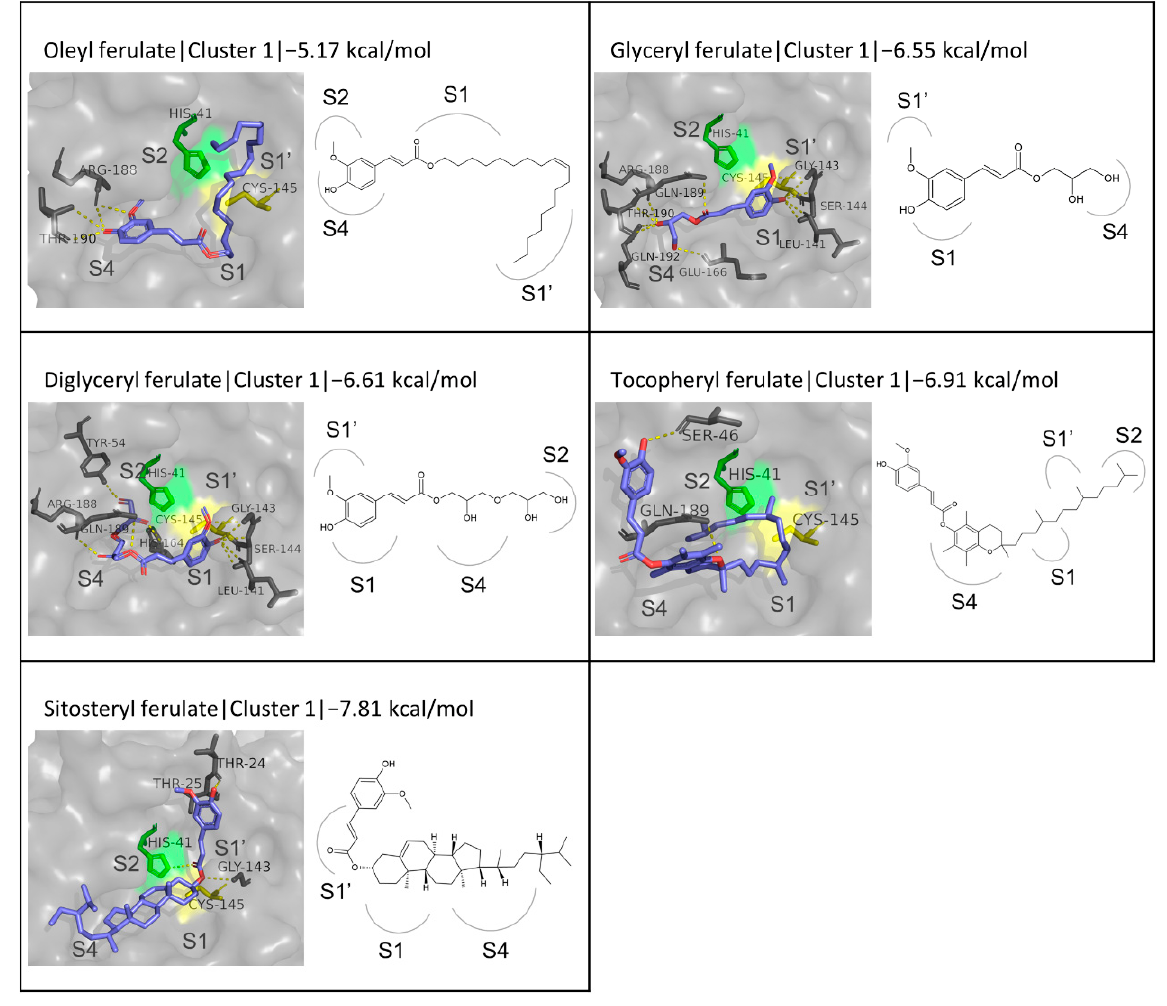
Figure 5. Structures and binding modes of fatty acid, polyol, tocopherol, and sterol FA derivatives at the active site of M pro .